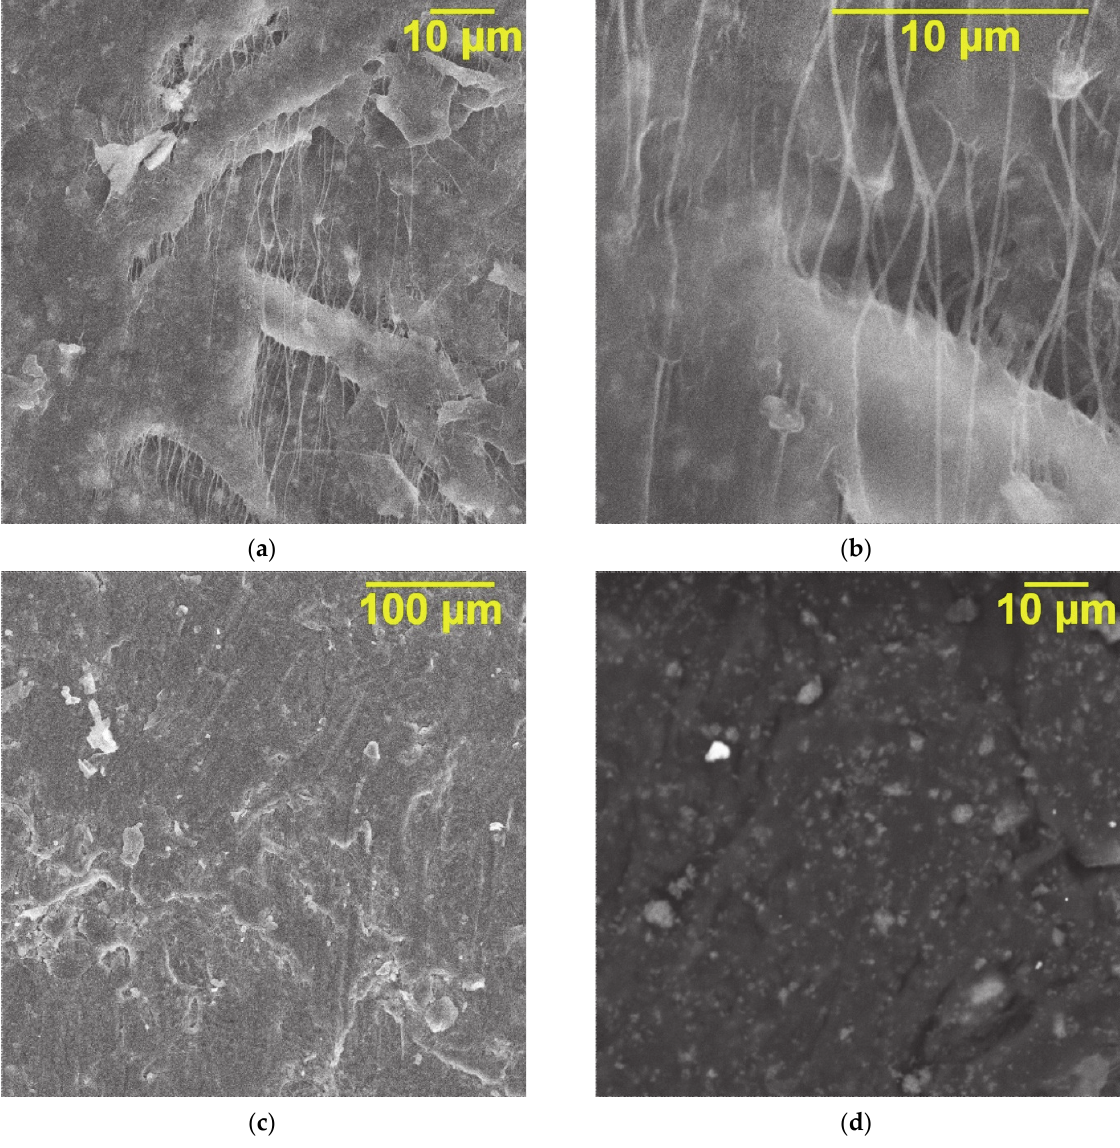
Figure 5. SEM images of PTFE/KFTO(H)@CB composites with 30 vol.% filler: ( a , b ) cross-section; ( c ) surface using primary electrons and ( d ) secondary electrons.